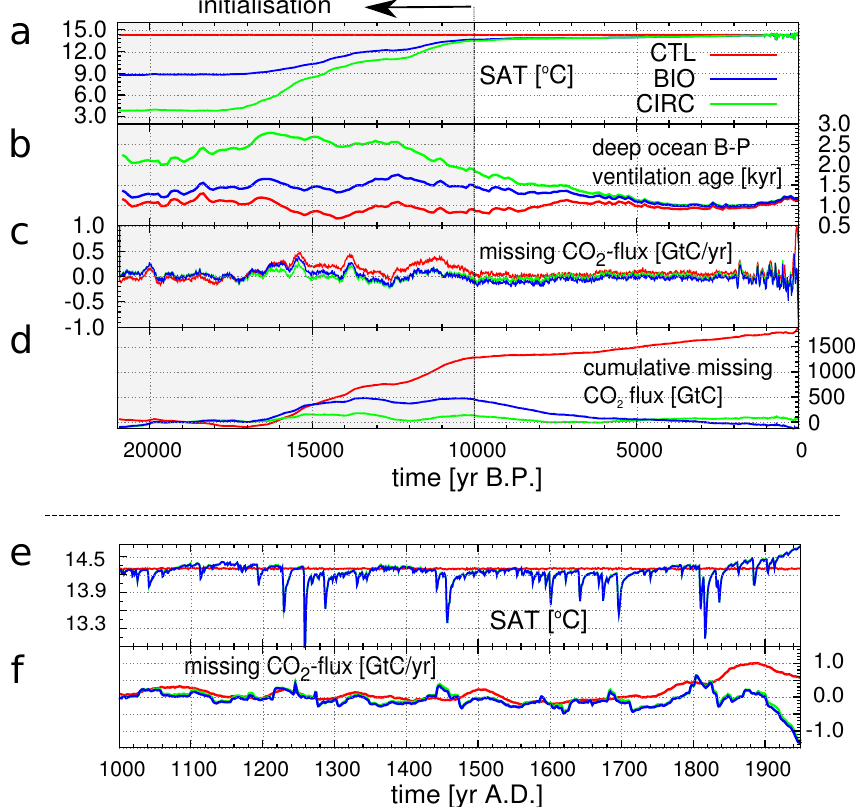
Fig. 6. Transient model response during the past 21kyr of (a) global mean surface air temperature (SAT), (b) globally averaged benthic- planktonic (surface-deep) reservoir age calculated as 14 C age offset from the global ocean below 2000m relative to the surface ocean, (c) implied carbon flux to solve the atmospheric budget ( F budget ) and (d) cumulative sum thereof for the experiments BIO, CIRC and the control run CTL. For the last millennium, SAT and F budget is shown in detail in the lower two panels (e, f) . The grey shaded area indicates the period used to initialise the model. The radiocarbon production rate is diagnosed only for the last